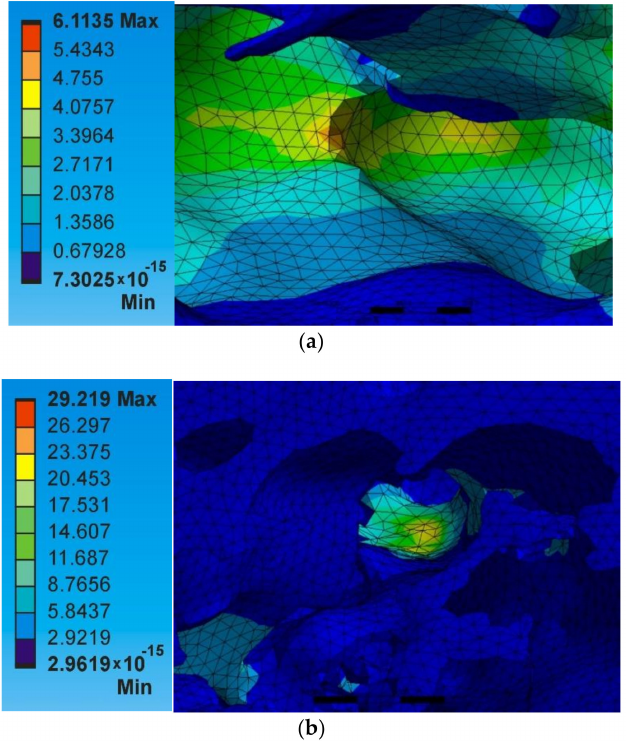
Figure 14. Heat flux (W/mm 2 ) distribution at the cell walls of the models with same porosity value ( a ) A1 × 11 and ( b ) A2 × 22—41% foam